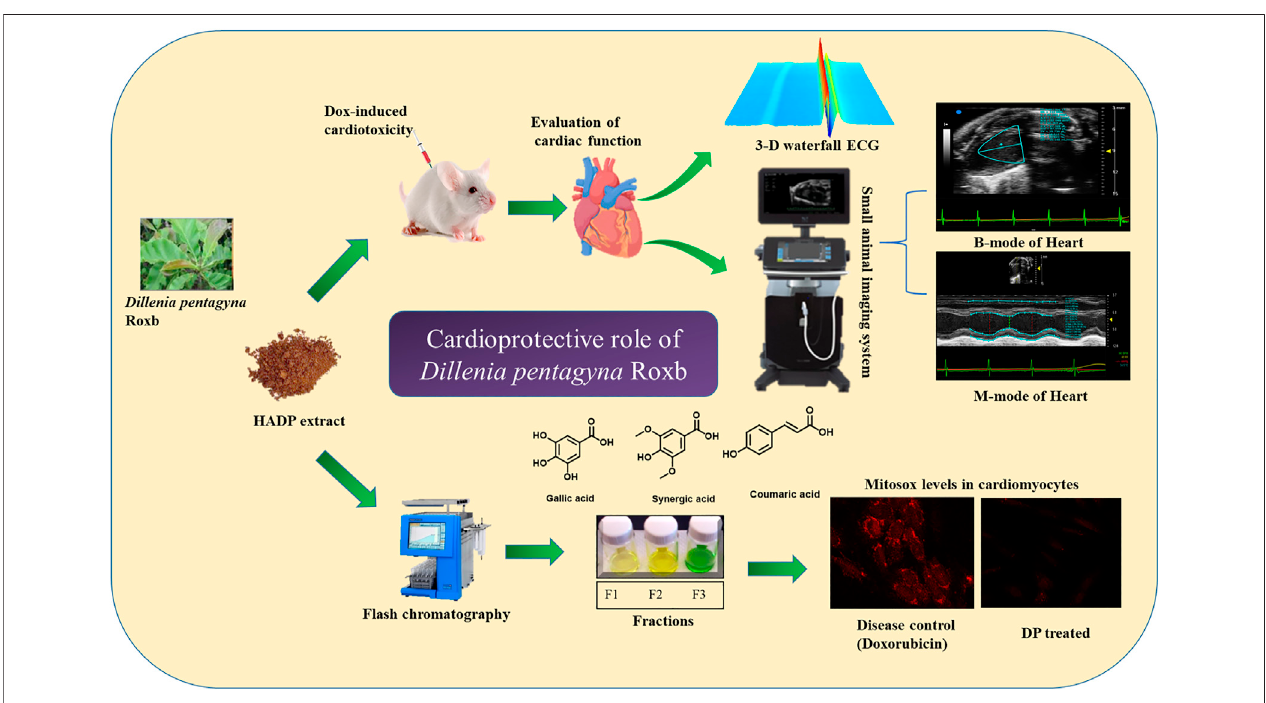
FIGURE 1 | Schematic representation of the proposed study design cardioprotective mechanism by the hydroalcoholic extract of DP.